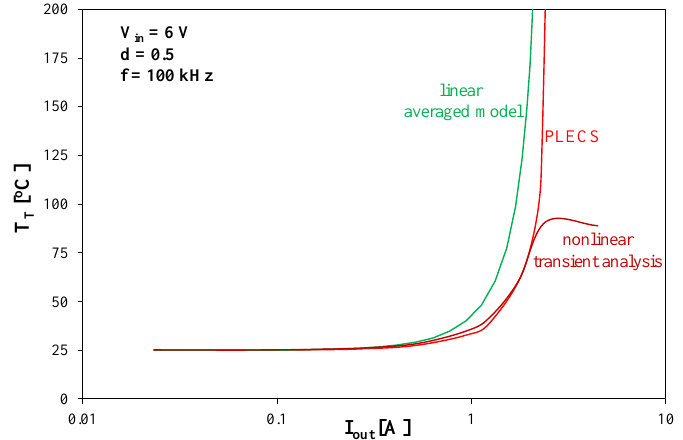
Figure 8. Computed dependences of the transistor internal temperature on the converter output current at V in = 6 V.